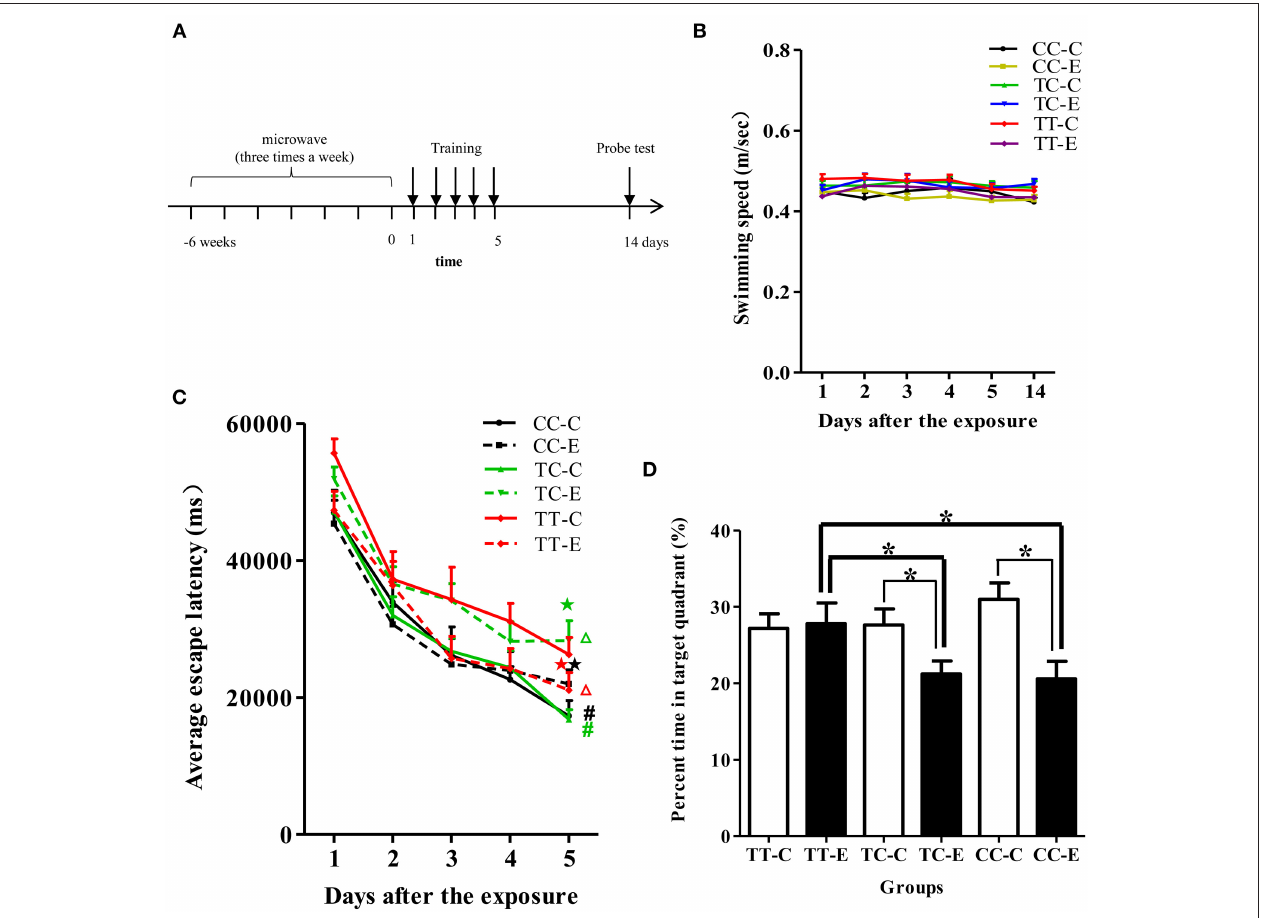
FIGURE 3 | Performance of rats in the MWM test. (A) Time schedule of the experiments. (B) Swimming speed of the rats. (C) AELs in the navigation test. Statistical significance (repeated measures ANOVA); changes in the exposed TC genotype (TC-E) and exposed TT genotype (TT-E) groups: 1 P < 0.05 vs. the control group of the same genotype; changes in the control TC genotype (TC-C) and control CC genotype (CC-C) groups: # P < 0.05 vs. the control TT genotype (TT-C) group; ⋆ P < 0.05 vs. control rats of the same genotype at the corresponding time point; (D) percentage of time spent in the target quadrant in the probe test. * P <